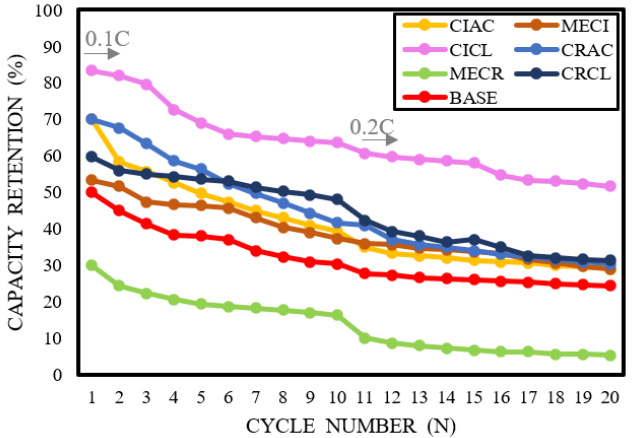
Figure 8. Comparing the cyclic performance of the base and the modified electrolytes at 45 °C.